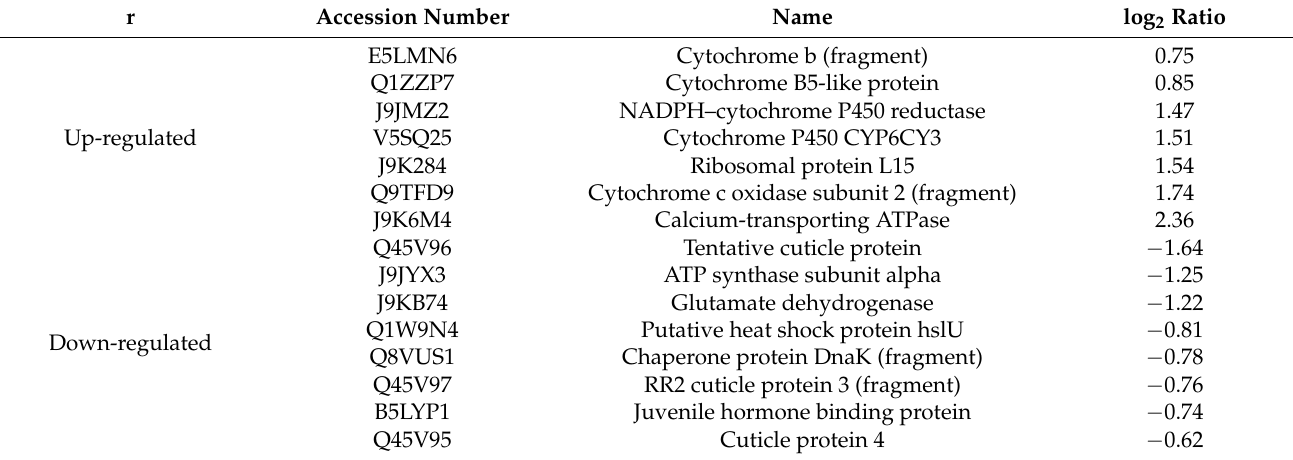
Figure 3. qRT-PCR validation of differential gene expression. ( A – C ) Transcript levels for 38 genes, of which 24 were up-regulated ( A ) and 14 were down-regulated ( B ), based on the RNA-seq and qRT-PCR expression data. ( C ) Comparison of the log-transformed gene expression ratios obtained from the RNA-seq data and qRT-PCR data for 38 DEGs. Table 3. Some of the important differentially accumulated proteins and their relative log 2 ratio between virus-infected and healthy M. persicae